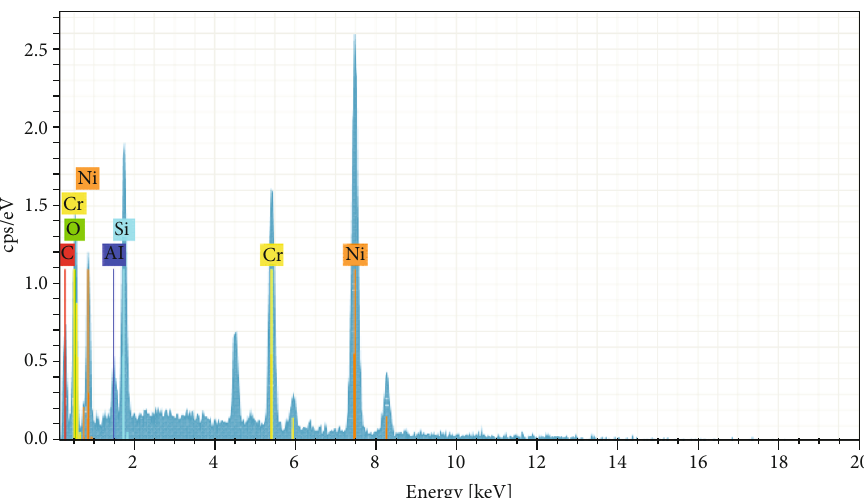
Figure 10: EDS for 0.3% volume concentration Al